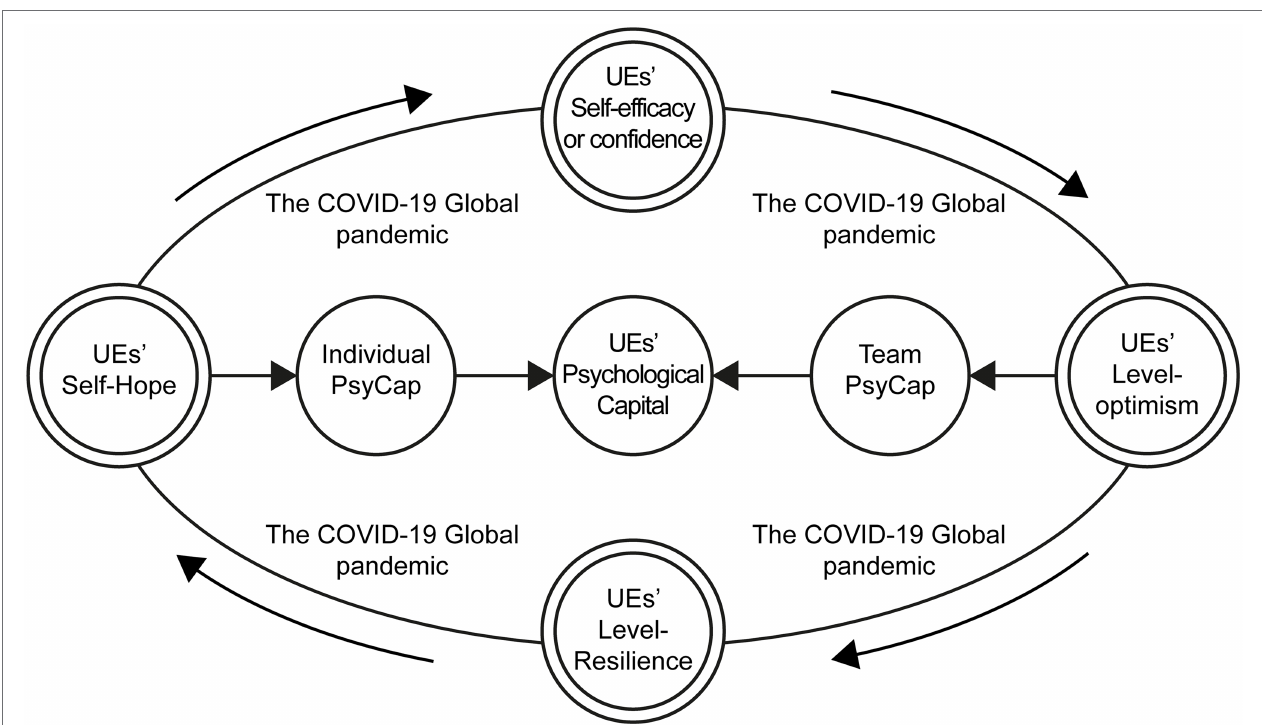
FIGURE 1 | Mechanism of the psychological capital structure of upper